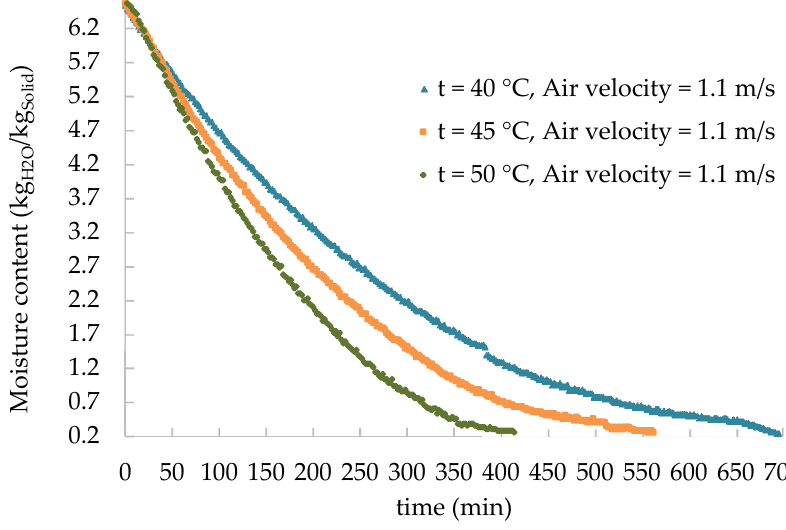
ff ect of temperature on dry basis moisture content (X). Figure 4. Effect of temperature on dry basis moisture content (X). Figure 4. E